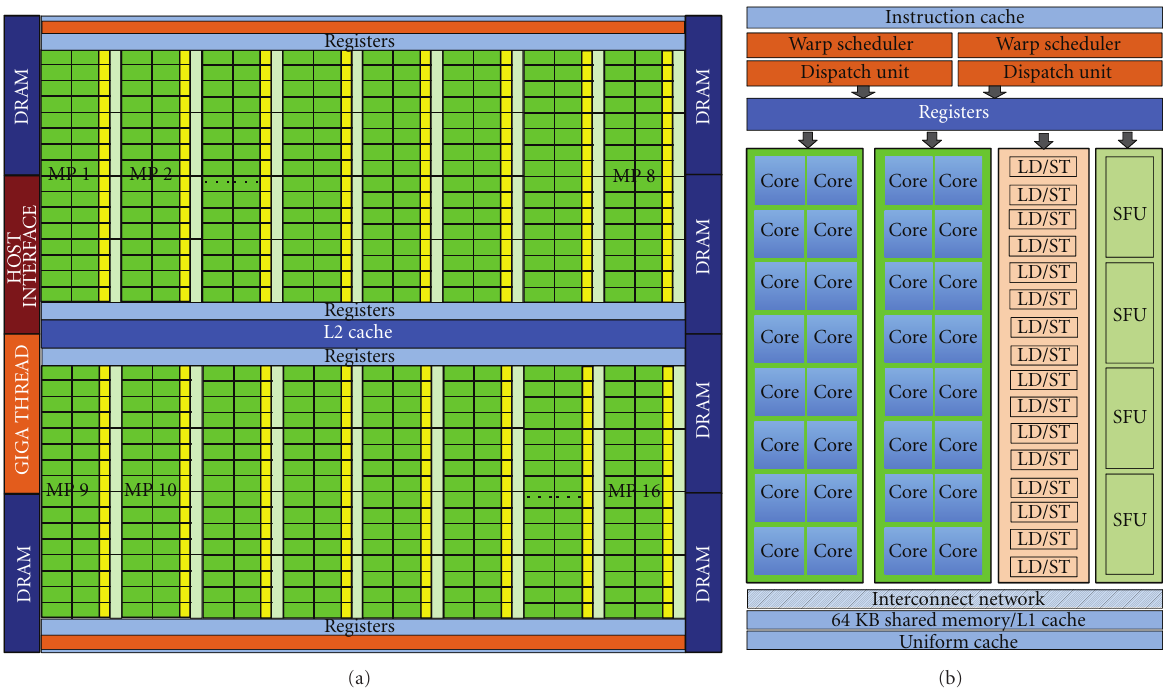
Figure 1: The overall architecture of a modern Fermi-based GPU device (a) and the inner details of a multiprocessor (b). Multiprocessors are configured around a shared level-2 cache and register files. Each multiprocessor has a number of computational cores and a level-1 cache. In the earlier versions of architectures such as C1060, these two cache levels do not exist, and the absence is facilitated by explicitly managed memories. This includes shared, constant, and texture memories. Image adopted from CUDA Programming Guide